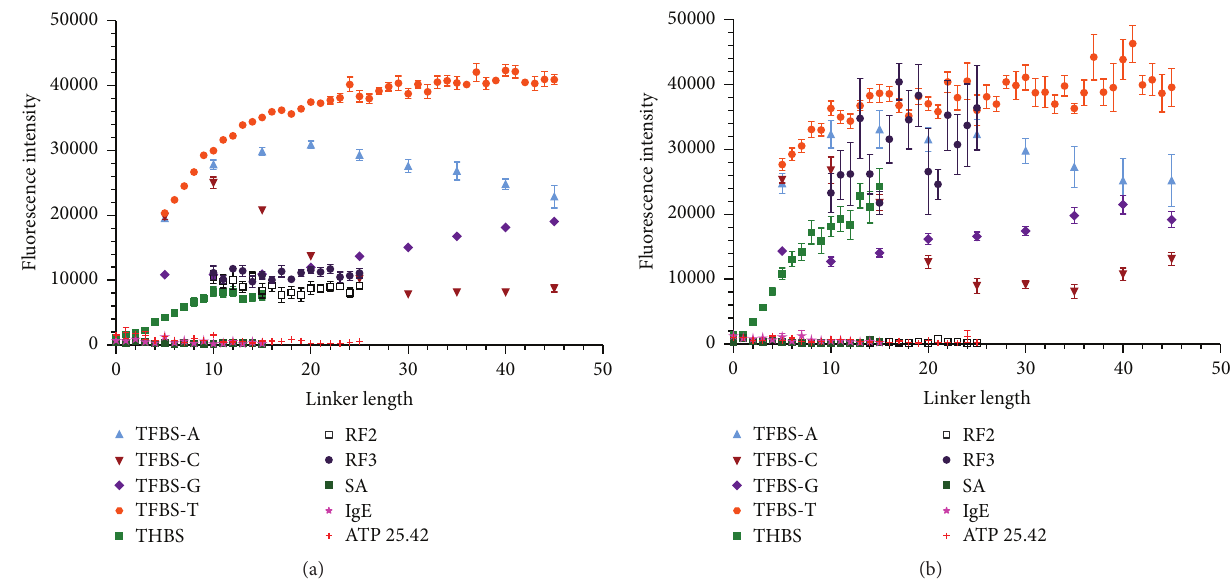
Figure 9: Binding of Cy3 dye to a variety of G-quartet and non-G-quartet aptamer sequences using (a) initial RF aptamer selection buffer; (b) PBSMTB without K + . Error bars represent SEM of raw fluorescence intensity values for 5–15 replicates of each sequence. Linker identity was T unless otherwise